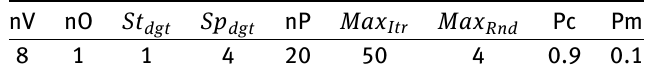
Table 11: VSSCGA Settings for Ackley’s function with 4